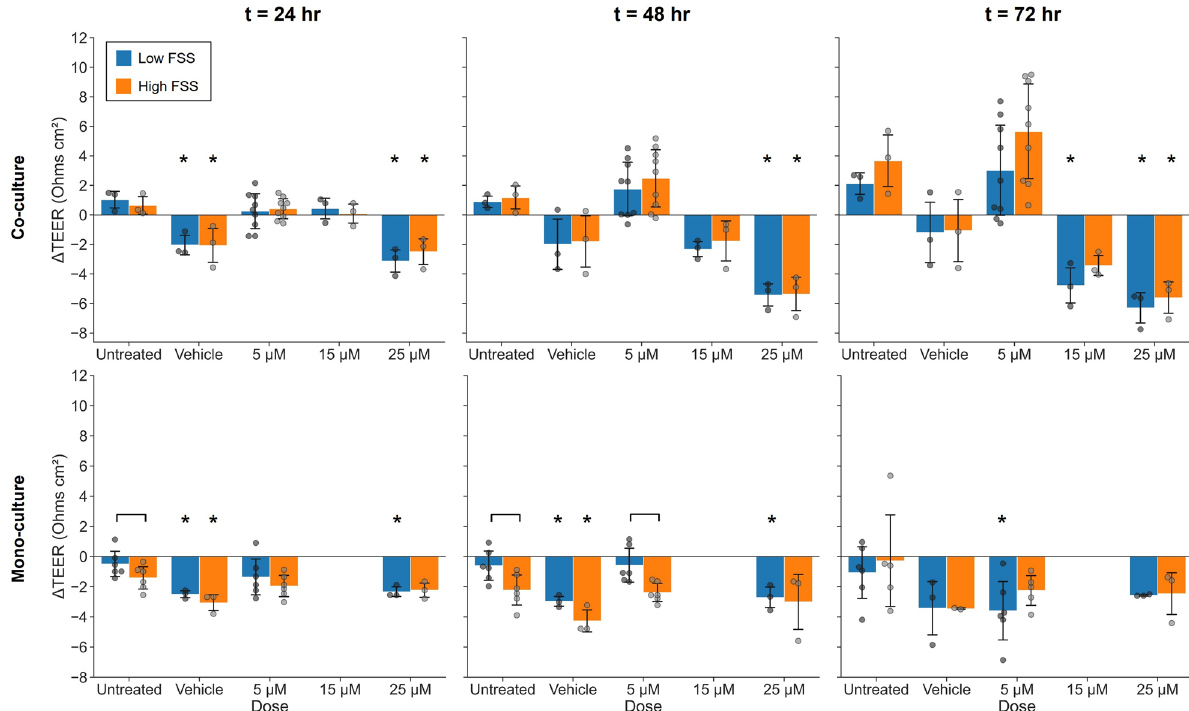
Figure 5. TEER sensing reveals dose-dependent changes in co-culture barrier function due to cisplatin exposure. Plots show the net change in TEER relative to baseline ( t = 0 h) at various time points during cisplatin exposure of co-cultures (top row) and mono-cultures (bottom row). Co-culture TEER decreased with exposure to 15 and 25 μM and persistently increased with 5 μM, whereas mono-culture TEER generally decreased independent of exposure. Bars represent mean ± SD of biological replicates. Co-culture: n = 3 devices per condition, except 5 μM cisplatin n = 9. Mono-culture: n = 6 for untreated and 5 μM low FSS, n = 5 for untreated and 5 μM high FSS, n = 3 for vehicle and 25 μM (except vehicle high FSS n = 2), and 15 μM not evaluated. N = 1 experimental replicate. * p ≤ 0.05 Kruskal–Wallis with Dunn’s post-hoc test relative to corresponding untreated culture control at same time point. Brackets indicate significant comparisons ( p ≤ 0.05) based on two-sided Mann–Whitney